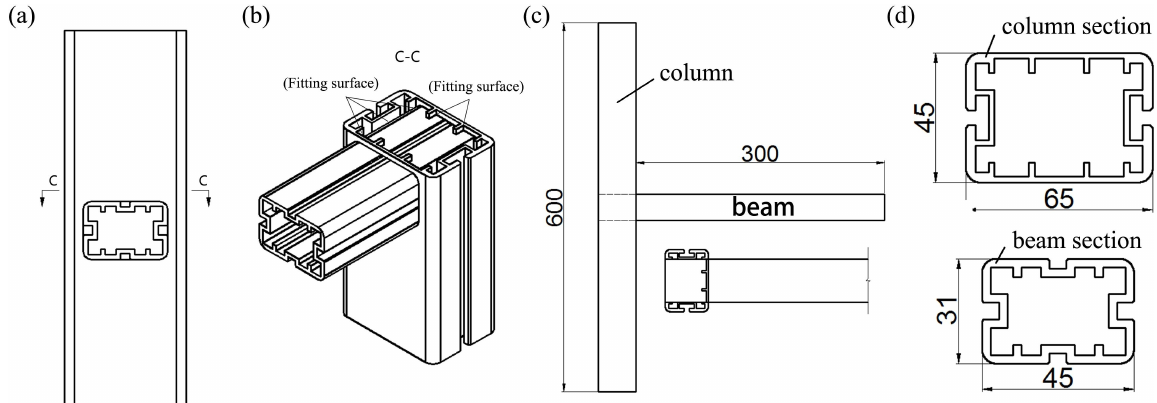
Figure 9: MT-T joint structure diagram